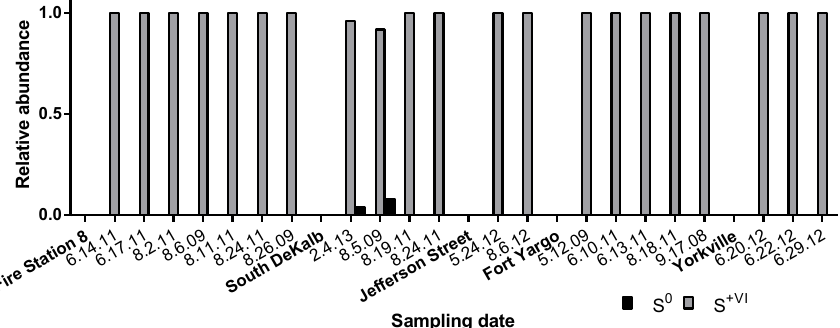
Figure 2. Bulk oxidation state of ambient particulate matter samples. Ambient particulate matter samples were characterized at the bulk level for oxidation state. Here, the fractional relative abundance of S 0 (black) and S + VI (grey) are shown for each of the ambient particulate matter samples. S 0 is only present in two samples collected from South DeKalb. The remaining samples contain only S + VI when examined in bulk.